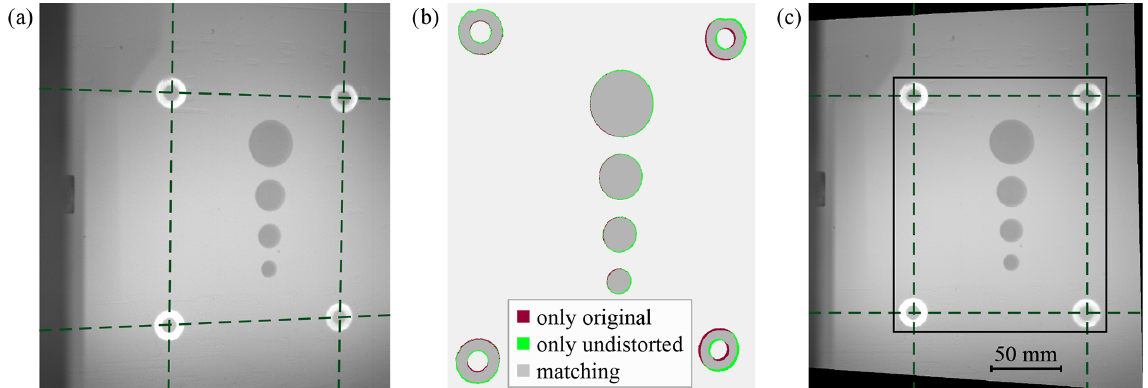
Figure 6. Correction of image distortion: (a) original image I, (b) differences of original and undistorted image, and (c) corrected (undistorted and rectified) image I’ with subsequent area restriction of the